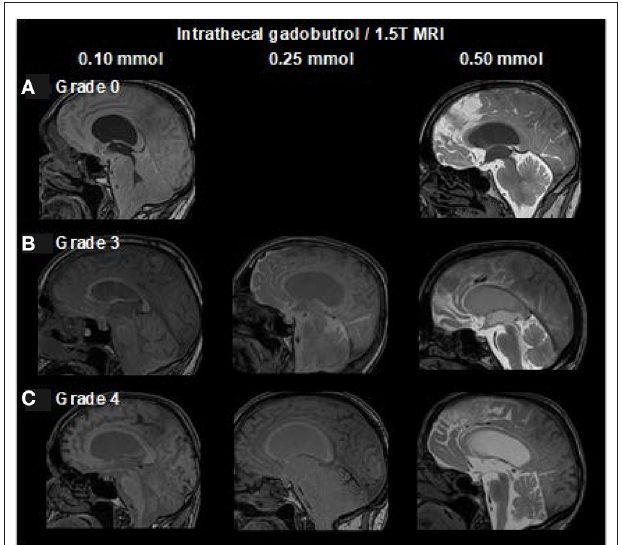
FIGURE 3 | Dose-dependent visualization of ventricular reflux of CSF tracer from sagittal reconstructed T1 weighted images (1.5T MRI) at 24h after intrathecal gadobutrol in doses of 0.10, 0.25, and 0.50 mmol. Ventricular reflux is categorized into five categories: (A) Grade 0: No supra-aqueductal reflux. Grade 1: Sign of supra-aqueductal reflux Day 1. Grade 2: Transient enrichment of lateral ventricles Day 1. (B) Grade 3: Lasting enrichment of lateral ventricles Day 2 (not isointense with CSF subarachnoid). (C) Grade 4: Lasting enrichment of lateral ventricles Day 2 (isointense with CSF subarachnoid). At